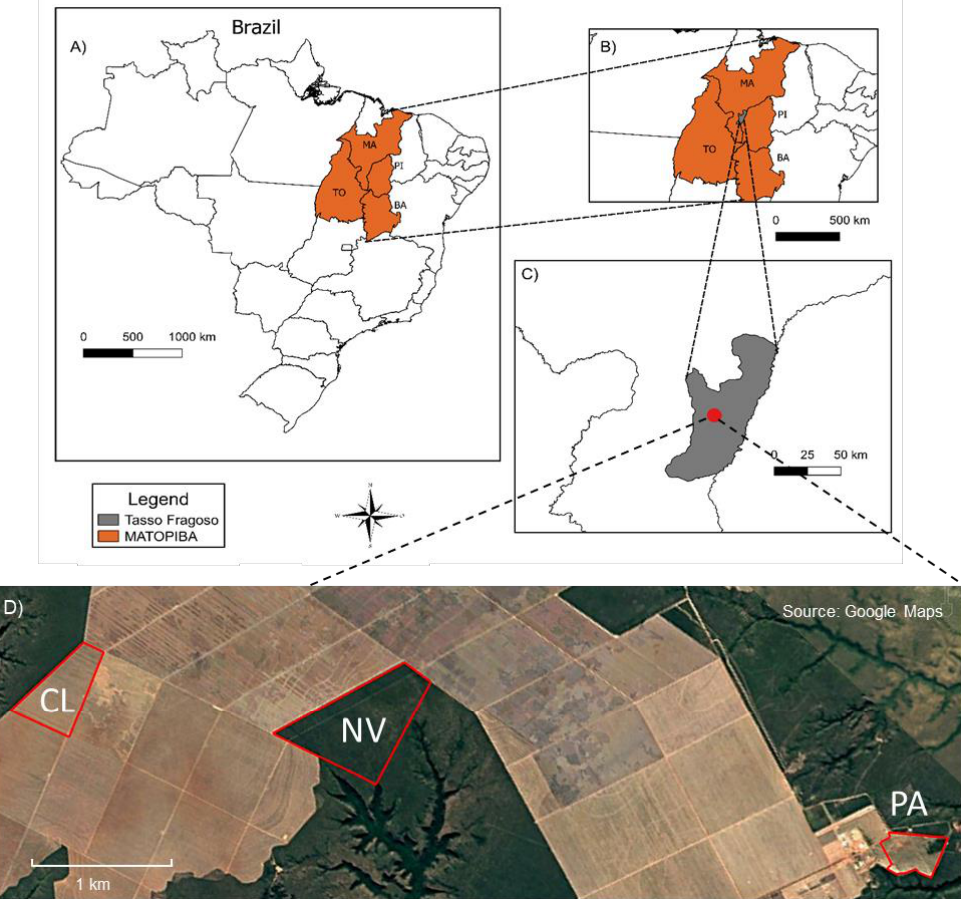
Figure 1. Location of the Matopiba region ( A ). County of Tasso Fragoso, Maranhão state ( B ). Assessed area location (red marker) ( C ). Field distribution of the sampled areas ( D ).